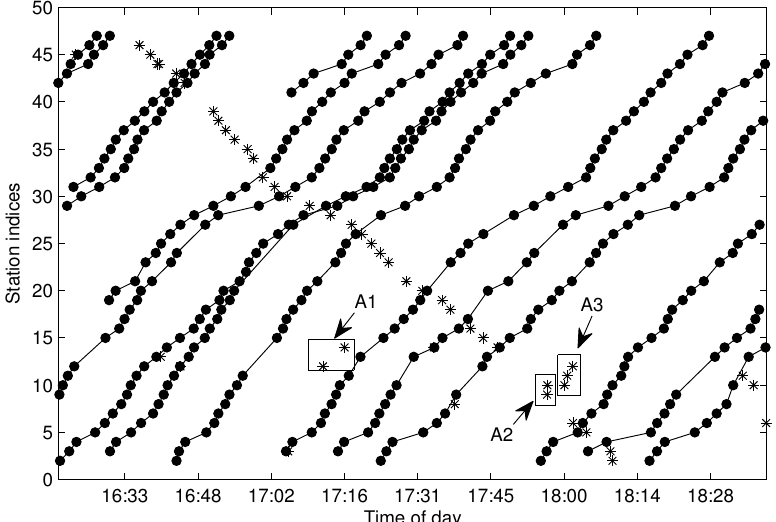
Figure 17. The cleaned trajectories after trajectory fragments connecting (TFC).